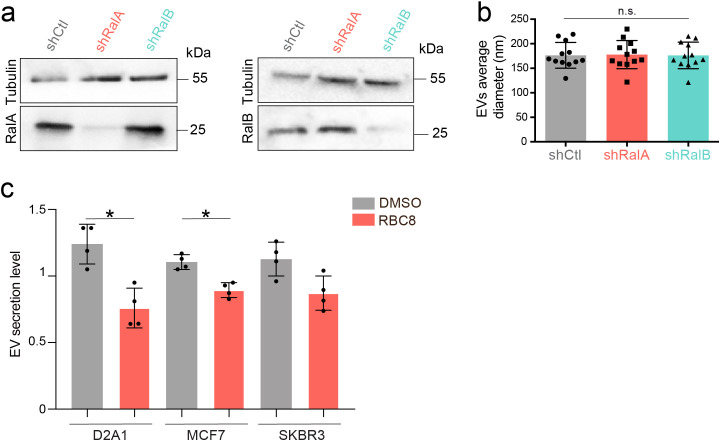
Ral knockdown efficiency and impact on EV secretion.(a) Representative western blots showing tubulin, RalA (left) and RalB (right) expressions in 4T1 shControl, shRalA, and shRalB cells. (b) Graph showing the average diameter of the extracellular vesicles (EVs) isolated from 4T1 shControl, shRalA, and shRalB cells measured by nanoparticle-tracking analysis. Each dot represents one experiment (12 independent experiments; One-Way Anova followed by Bonferroni's Multiple Comparison Test). (c) Nanoparticle-tracking analysis of EVs isolated by ultracentrifugation (100,000 g pellet) from the supernatant of various breast cancer cell lines treated with the Ral inhibitor RBC8. Each dot represents one experiment (four independent experiments, Mann Whitney test, p value indicated on the graph).